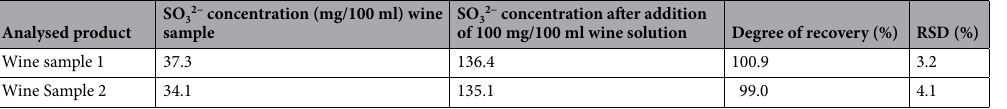
Table 2. Real sample analysis of SO 32− trace in wine samples by DPV technique using CuO/GCE.